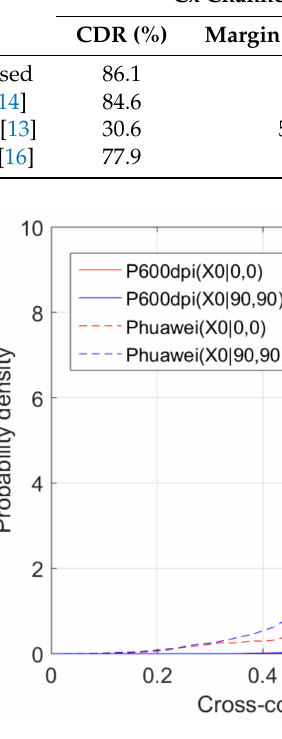
Figure 8. Two probability densities of extracted features, p ( x 0 ◦ | 0 ◦ ,0 ◦ ) and p ( x 0 ◦ | 90 ◦ ,90 ◦ ) , estimated from the Epson 600 dpi scans (solid line) and Huawei camera captures (dashed